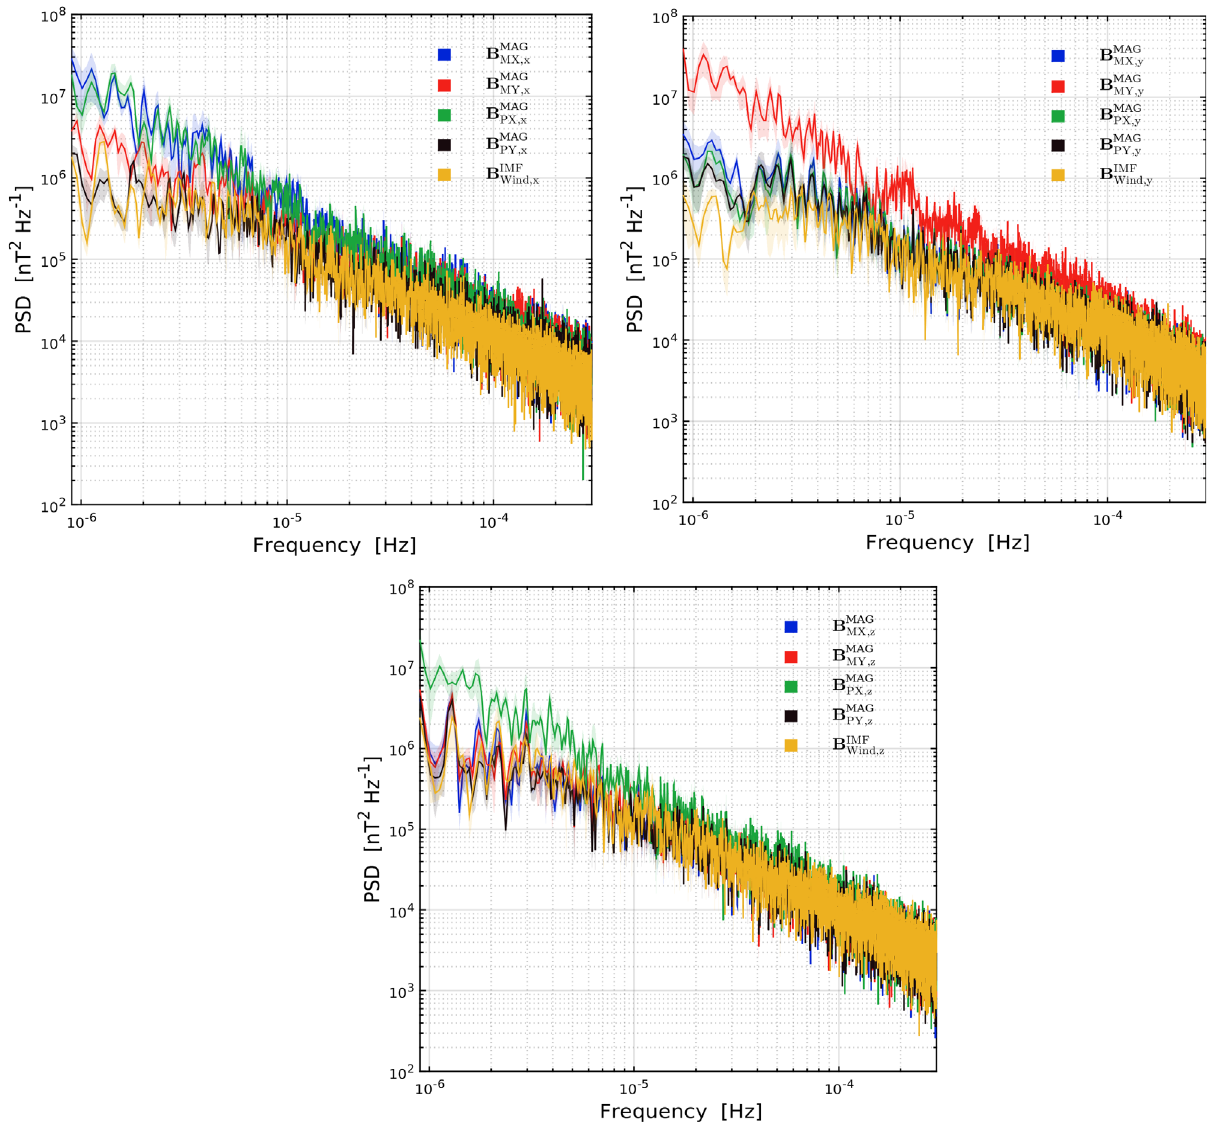
Figure 3. PSDs of LPF and Wind 3-axis magnetometer simultaneous measurements (from February 20, 2016, through June 21, 2017). All measurements were reported in the R LTP reference frame for proper